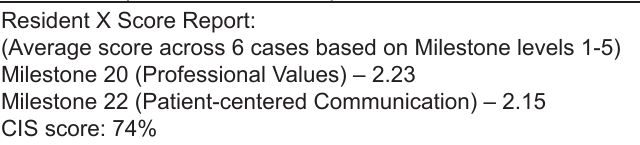
Table 2. Sample resident score